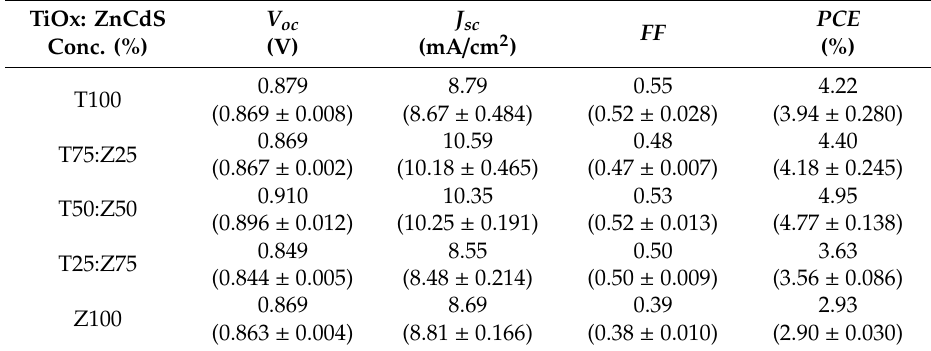
Figure 1. ( a ) SEM cross-sectional image, ( b ) J-V characteristics of perovskite solar cells, ( c ) Nyquist plot, ( d ) Bode plot and ( e ) Mott-Schottky plot of perovskite solar cells fabricated from different ratio of TiO x :Zn 1−x Cd x S. Table 1. Performances of polymer solar cells fabricated from different T:Z ETL.